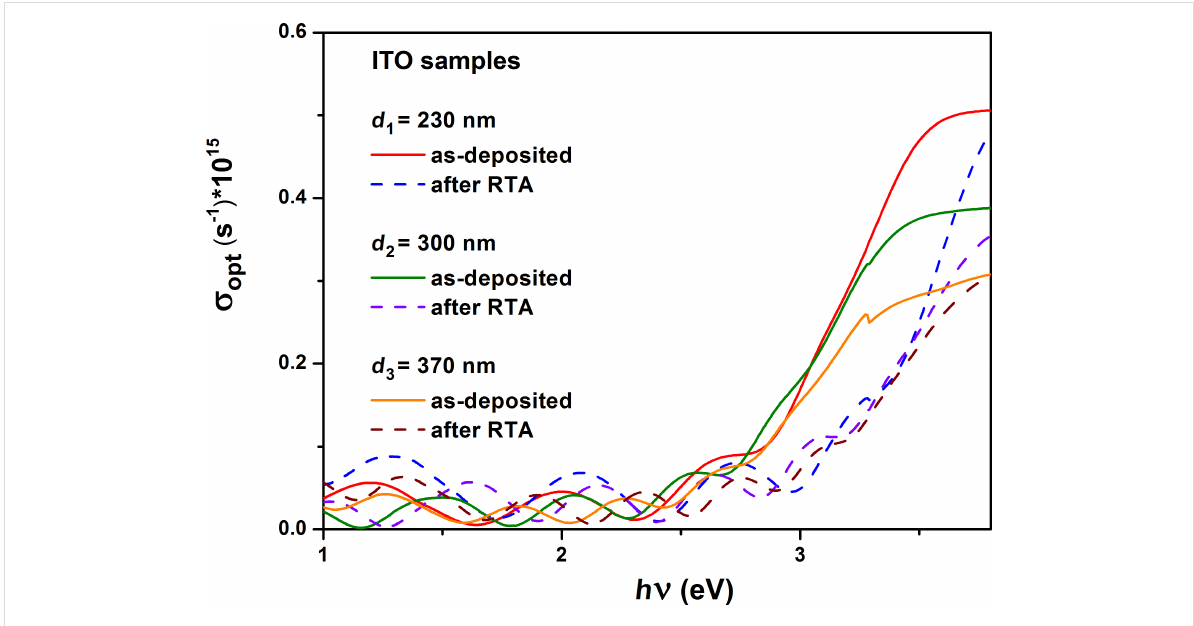
Figure 8: Optical conductivity dependence on the energy of the incident photons for the as-deposited and RTA-treated ITO samples.